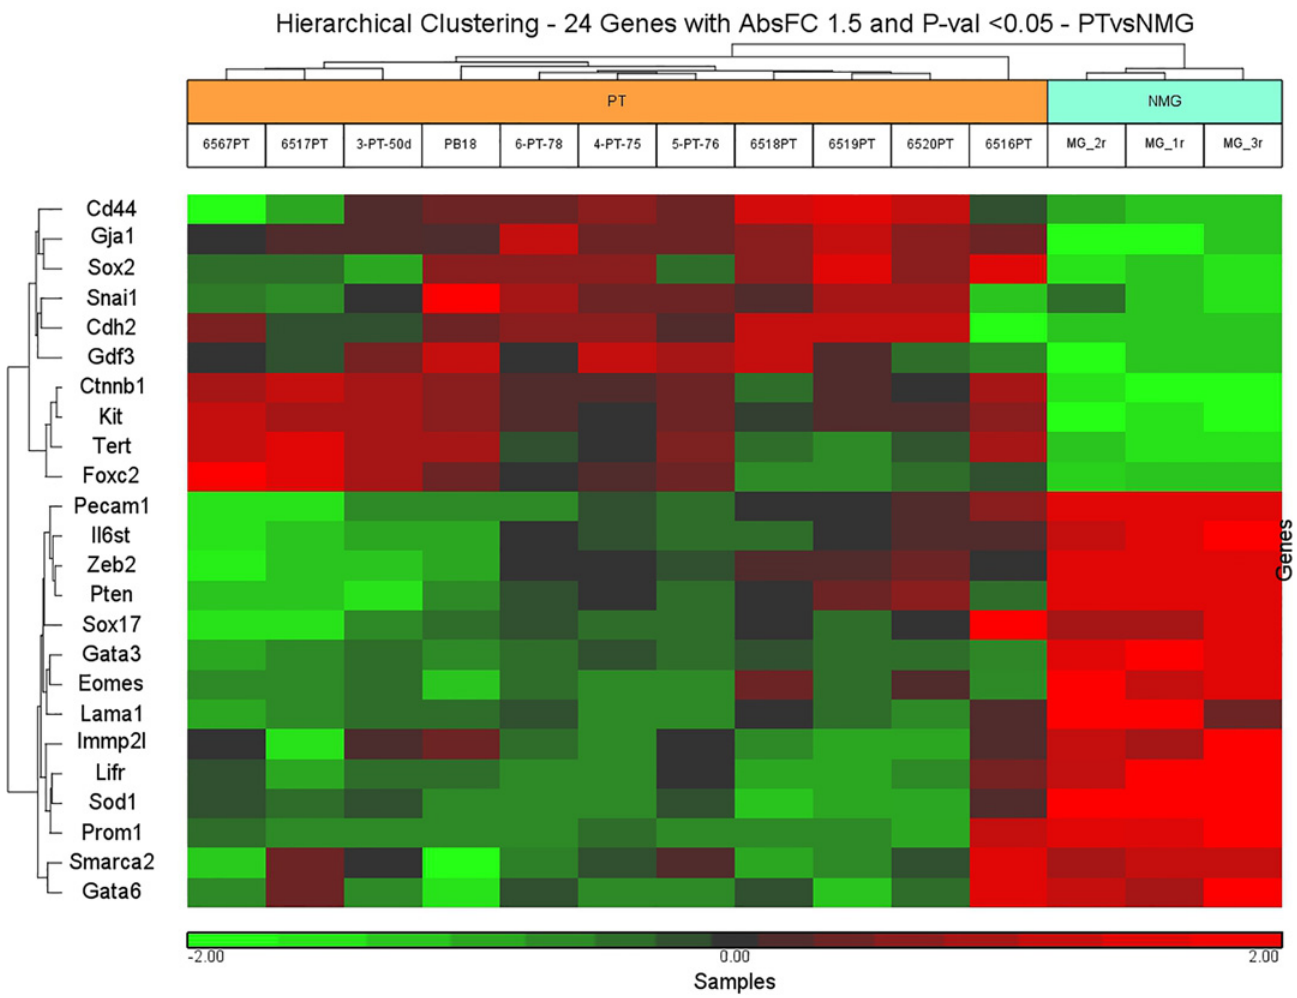
Fig 4. Unsupervised hierarchical clustering of normal mammary gland versus primary tumor. Scaled down representation of the entire cluster is based on 24 genes differentially expressed between normal mammary gland (NMG) and primary mammary tumors (PT). Each row represents a single gene and each column represents a sample. Red color indicates upregulation, green color — downregulation, and black color — no change in expression level compared with the reference sample.